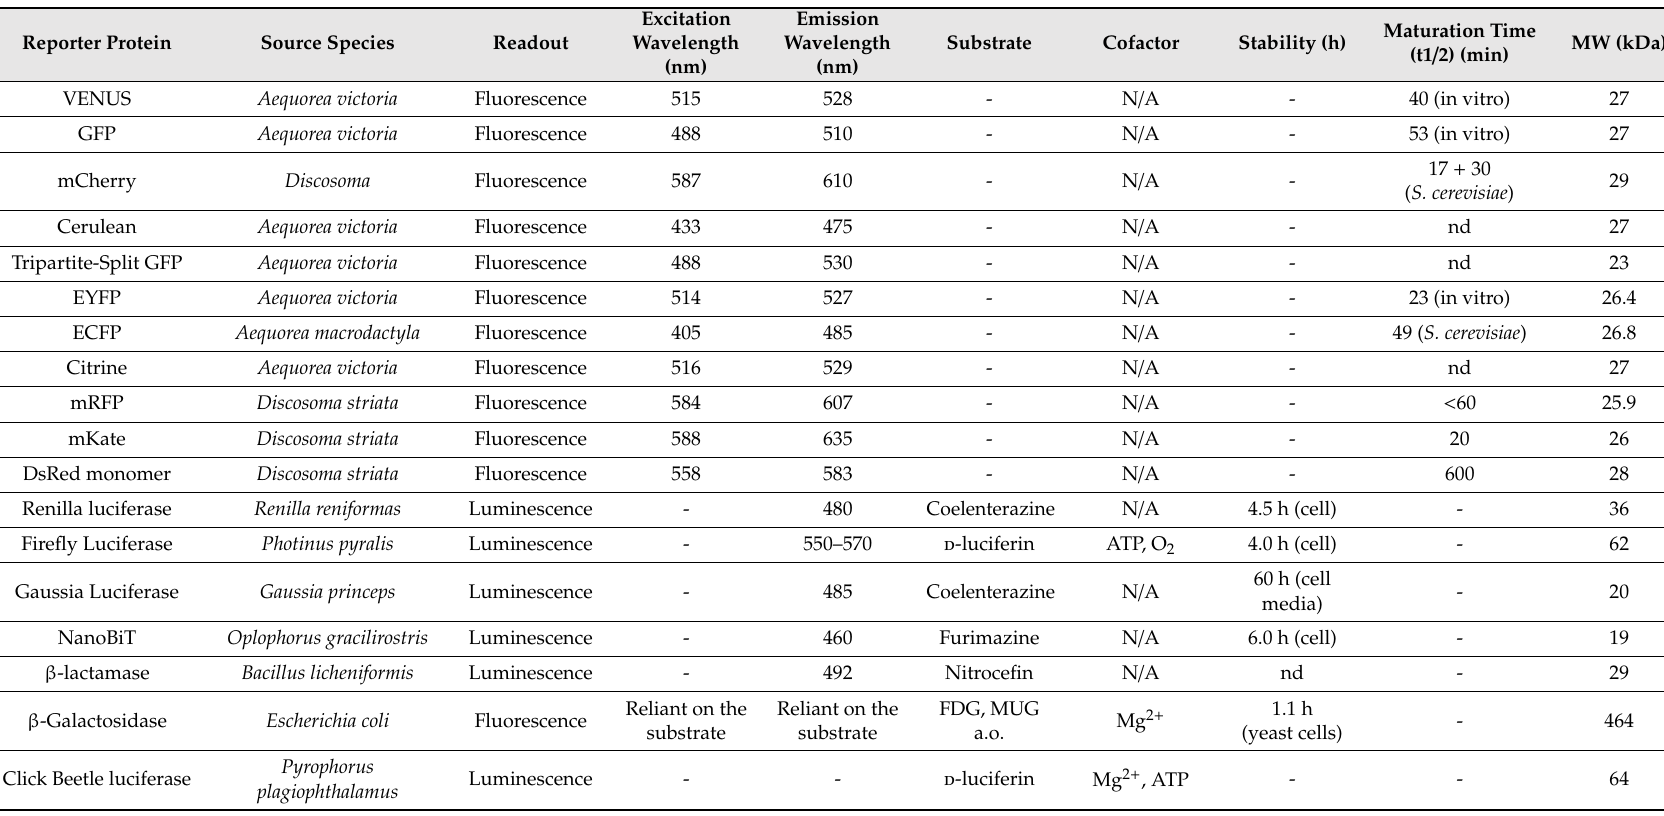
Table 1. Overview of proteins, already implemented in fluorescence- and luminescence-based complementation assays. N / A = not applicable, nd = not determined. Reporter